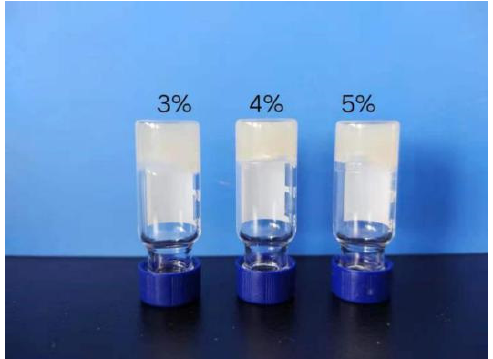
Figure 4. Tube inversion test at different gel concentrations (3%, 4% and 5%).